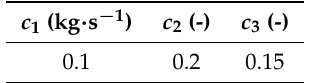
Table 1. Valves’ parameters used in this